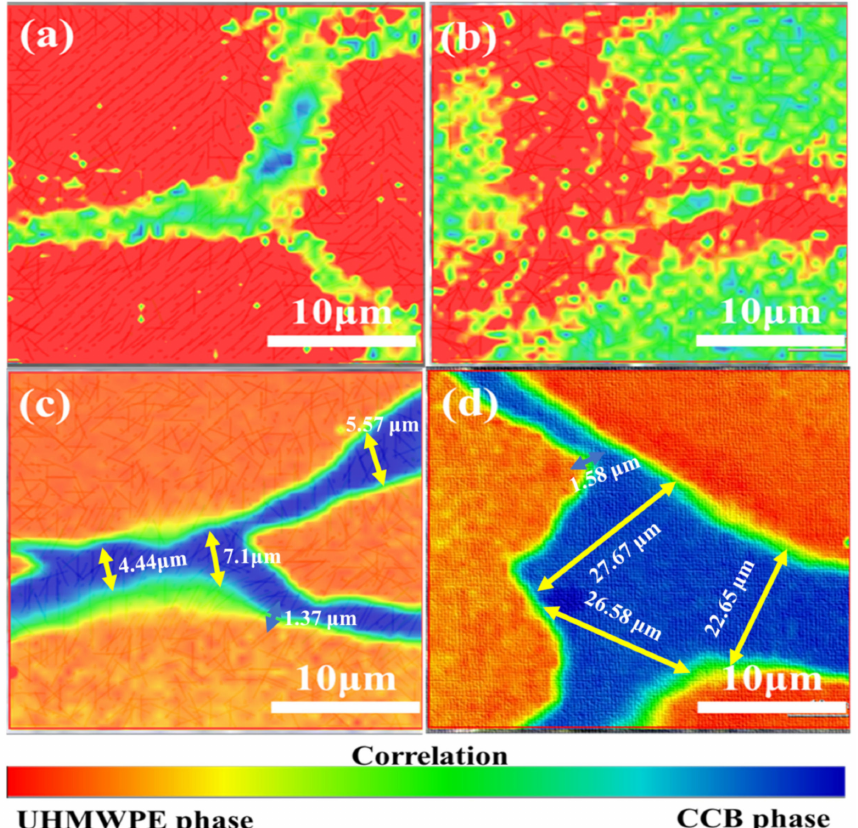
Figure 5. Raman mapping images of UHMWPE/CCB composites with different concentrations: ( a ) UHMWPE/1-CCB 1 ; ( b ) UHMWPE/1-CCB 3 ; ( c ) UHMWPE/h-CCB 1 ; and ( d ) UHMWPE/h-CCB 3